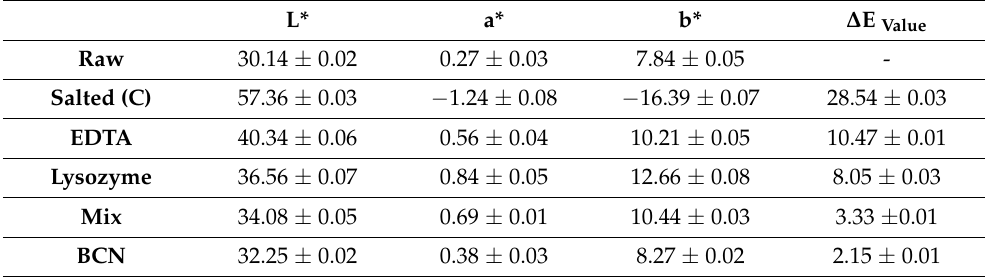
Table 4. The changes in color attributes of commercial and treated coating mullet compared to raw